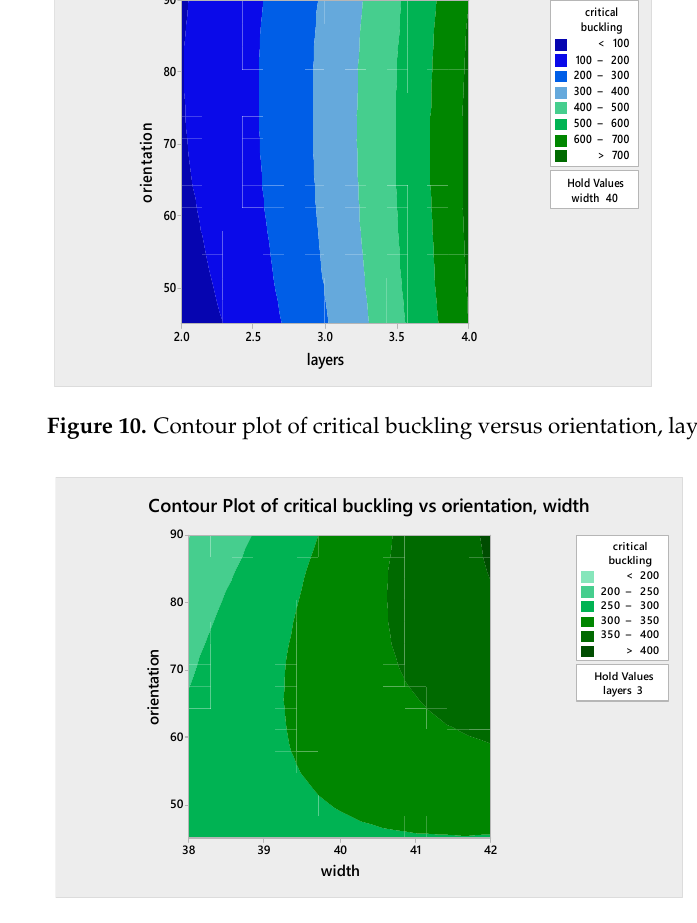
Figure 12. Contour plot of critical buckling versus width, layers. From the normal probability plot for the response of the critical buckling load given in Figure 9, it was noted that all of the data points fell closely along the straight distribu- tion line. This clearly represented that the plot obtained had a good fit with the data. Figure 10 clearly depicts that when the number of layers increased, the critical buck- ling value also increased for the width of 40 mm. It was noted that the influence of orien-